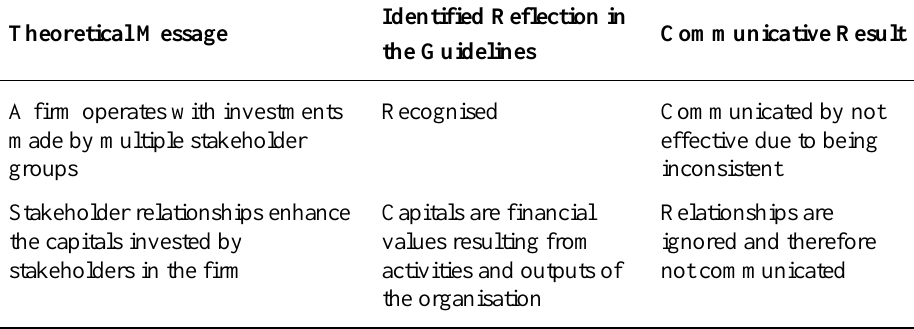
Table 2: Communication of Four